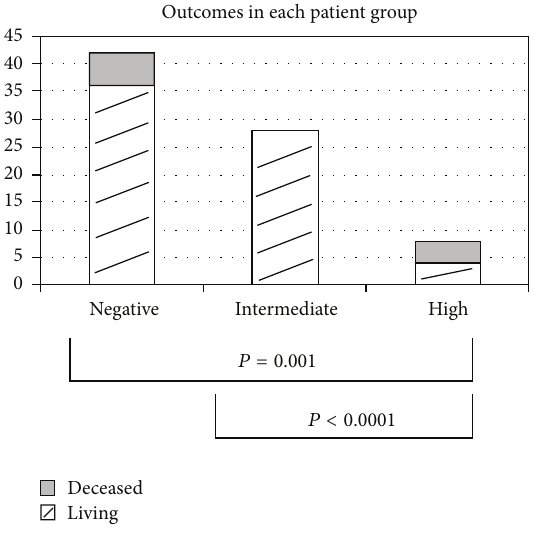
Figure 2: Overall outcomes in each patient group.